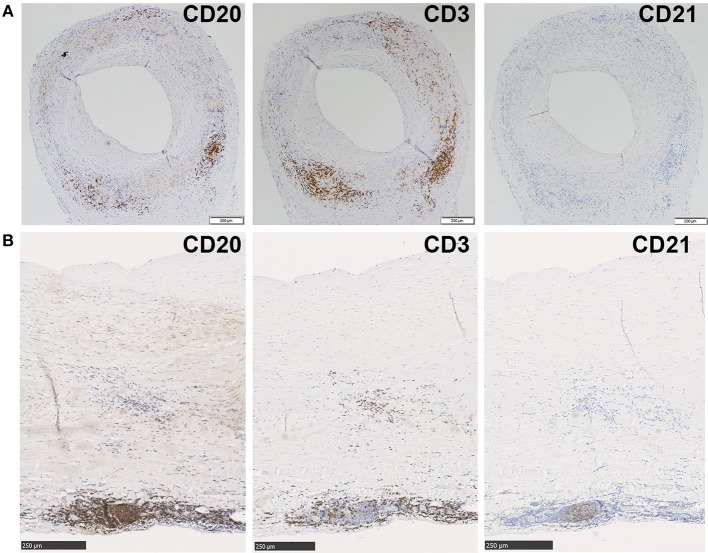
B-cell, T-cell and FDC network staining in TAB and aorta tissue from one patient who experienced C-GCA 5 years before aneurysm surgery. Immunohistochemical stainings show from left to right, CD20+ B-cells, CD3+ T-cells, and no CD21+ FDC network in consecutive sections of a GCA positive TAB (A) and CD20+ B-cells, CD3+ T-cells and a clear CD21+ FDC network in consecutive sections of GCA positive aorta (B).